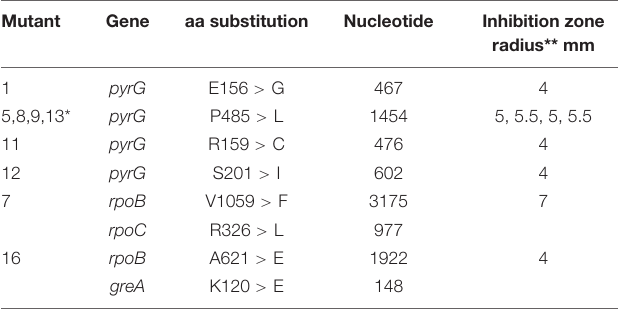
TABLE 2 | Locations of the IQC-resistance mutations and predicted effects and disc diffusion assay results. Mutant Gene aa substitution Nucleotide Inhibition zone